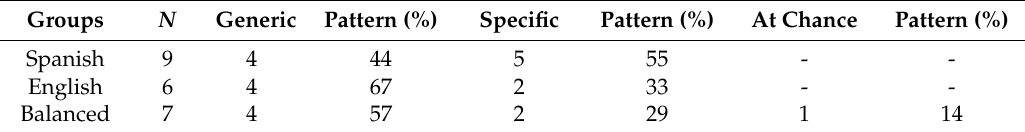
Table 5. Bare NPs: Individual subject patterns by amount of